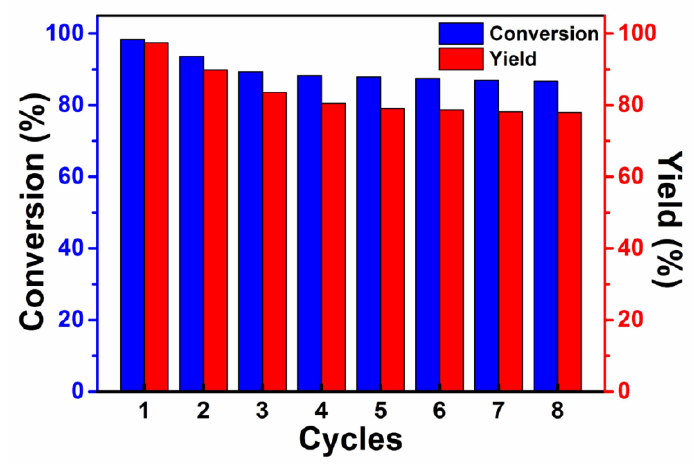
Figure 6. Effect of the catalyst circulation on catalytic performance.